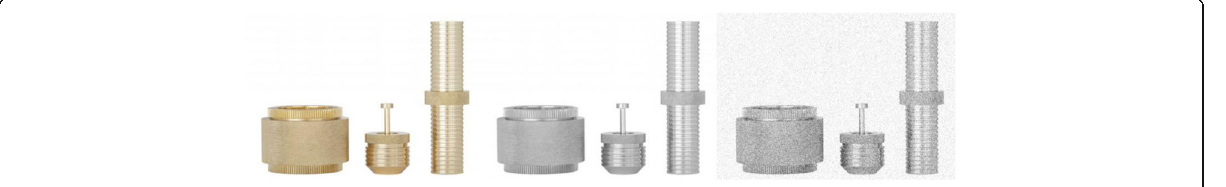
Fig. 2 Original image, grayscale image, and noisy